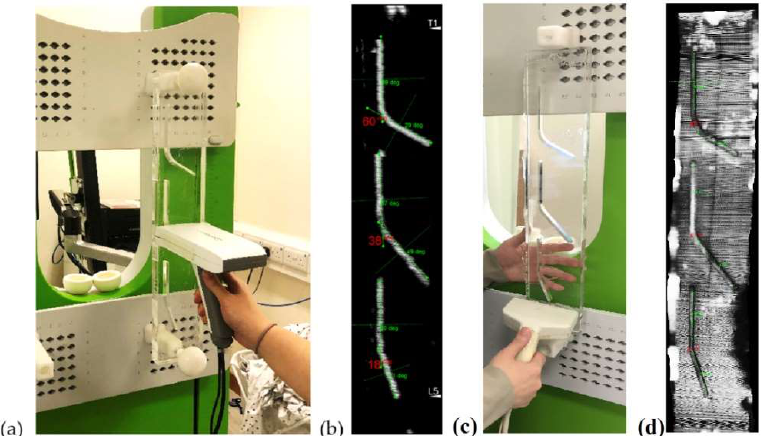
Figure 3. ( a ) A typical setup for scanning the plastic angle phantom using Scolioscan Air; ( b ) A typical image obtained from the angle phantom showing the three angles (60, 40, 20 degrees by design) and lines drawn for the angle measurement manually; ( c ) Same setup for scanning the phantom using Scolioscan; ( d ) A typical image obtained using Scolioscan with the same scanning and measurement procedures.